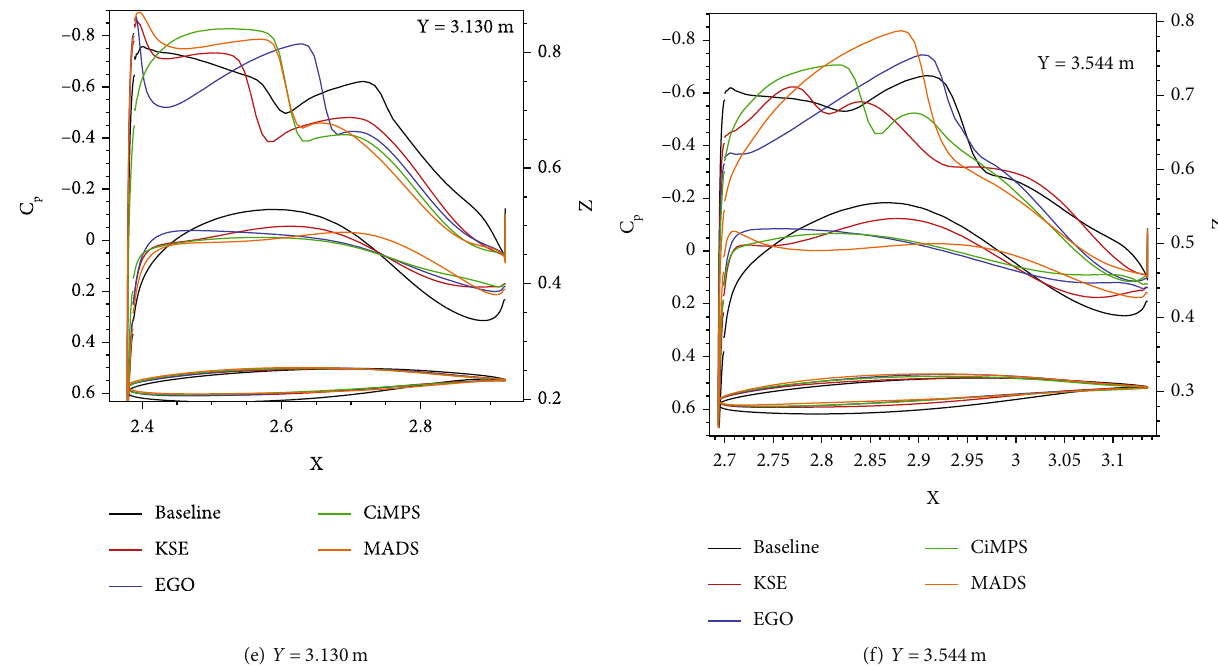
Figure 28: Geometry and pressure distributions at a di ff erent section of the baseline model and optimized